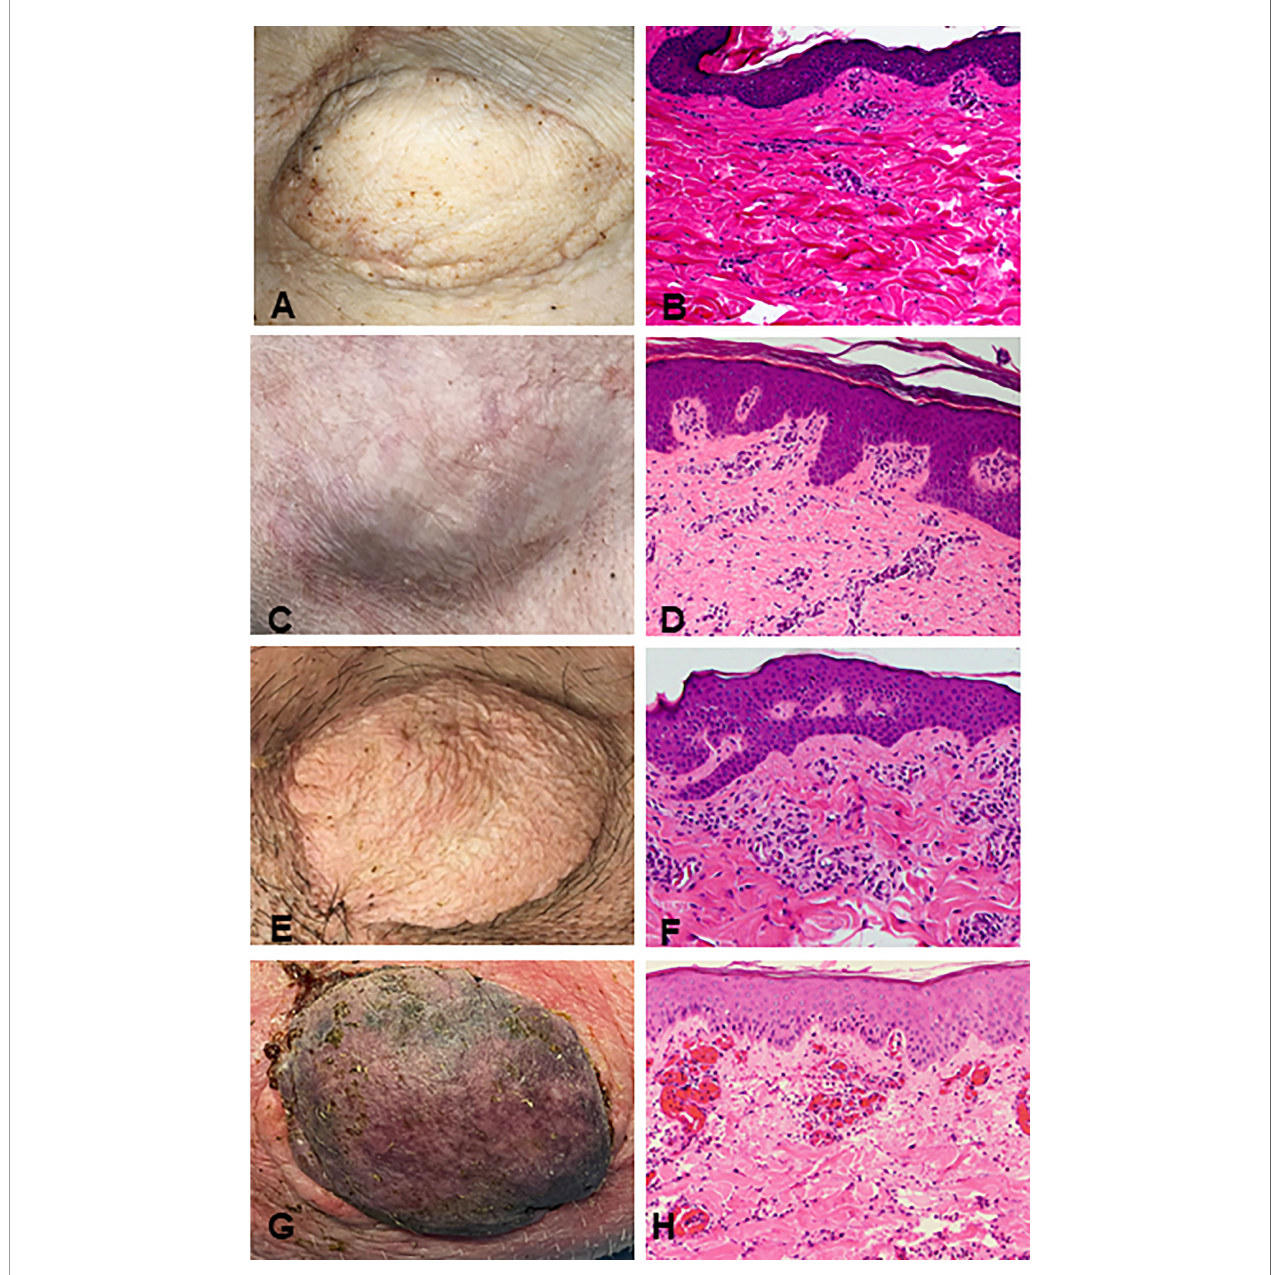
FIGURE 2 | Clinical assessment of successful VCA tolerance. Images of tolerant VCAs from R3 (A) , R4 (C) , and R5 (E) taken on POD 251, 387, and 250, respectively, compared to a representative rejected VCA from untreated control R6 on POD 11 (G) . H&E staining of VCA biopsies from R3 (B) , R4 (D) , and R5 (F) , taken on POD 151, 387, and 250 respectively, demonstrating absence of rejection (Banff Grade 0). Whereas H&E staining of VCA skin from class I mismatch untreated control R6 shows focal epidermal necrosis and capillary thrombosis (Banff Grade IV) on POD 11 (H) . (POD, post-operative day; VCA, vascularized composite